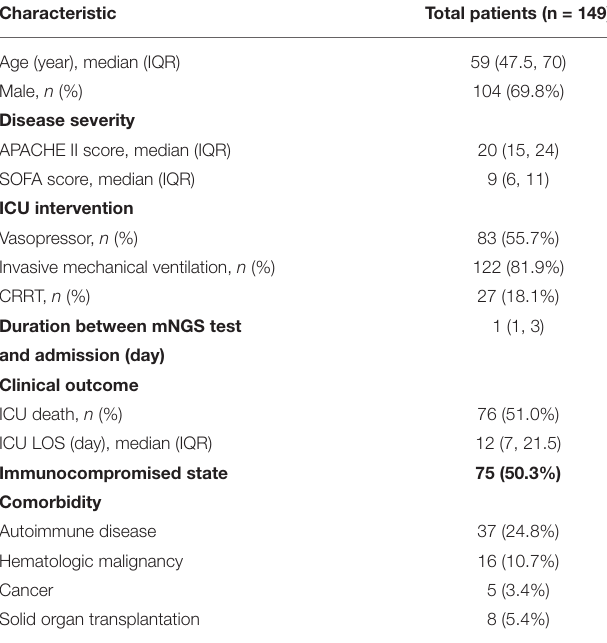
TABLE 1 | Patient characteristics and clinical outcome.